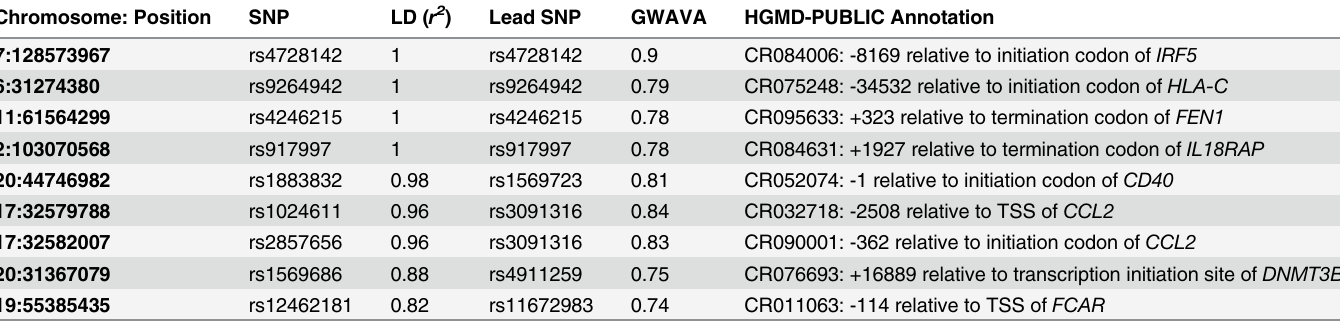
Table 1. List of SNPs with high GWAVA scores and HGMD-PUBLIC regulatory